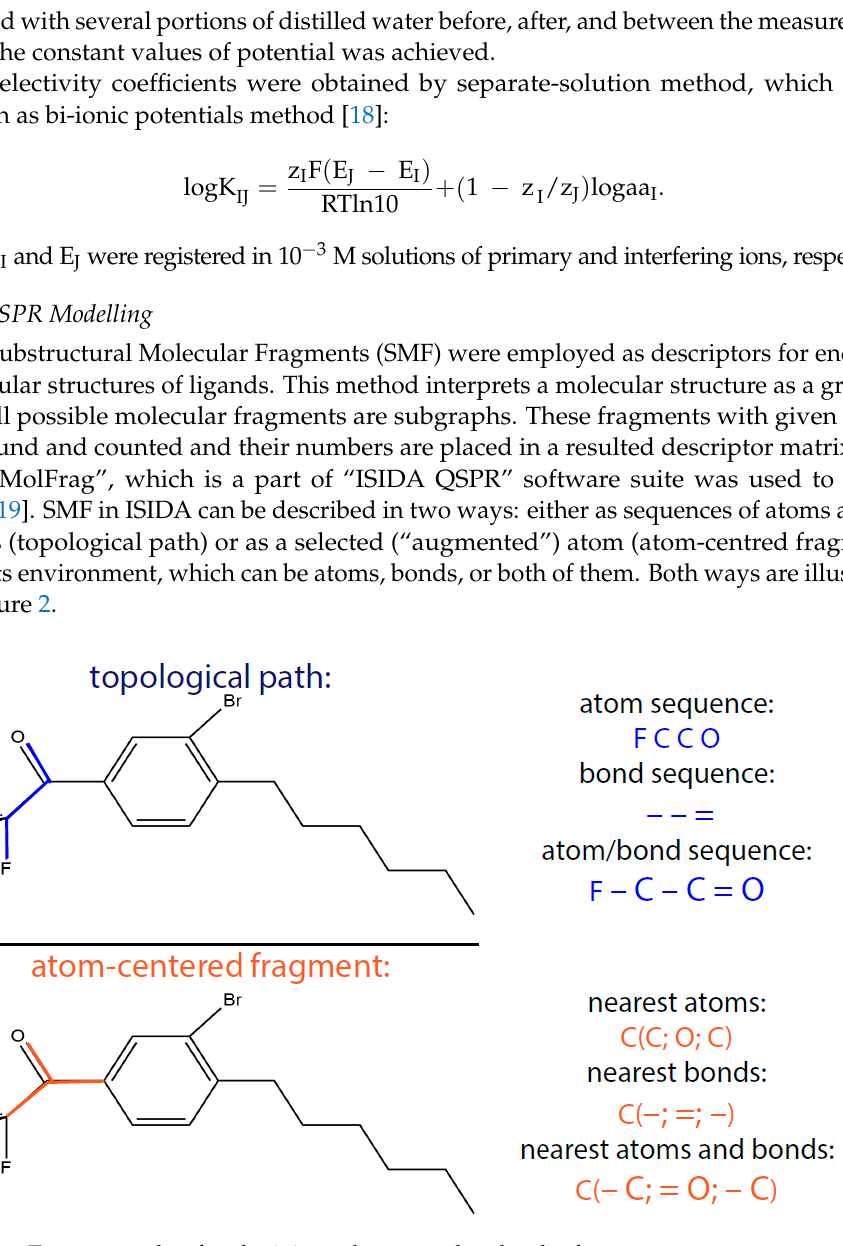
Figure 2. Two approaches for obtaining substructural molecular fragments.